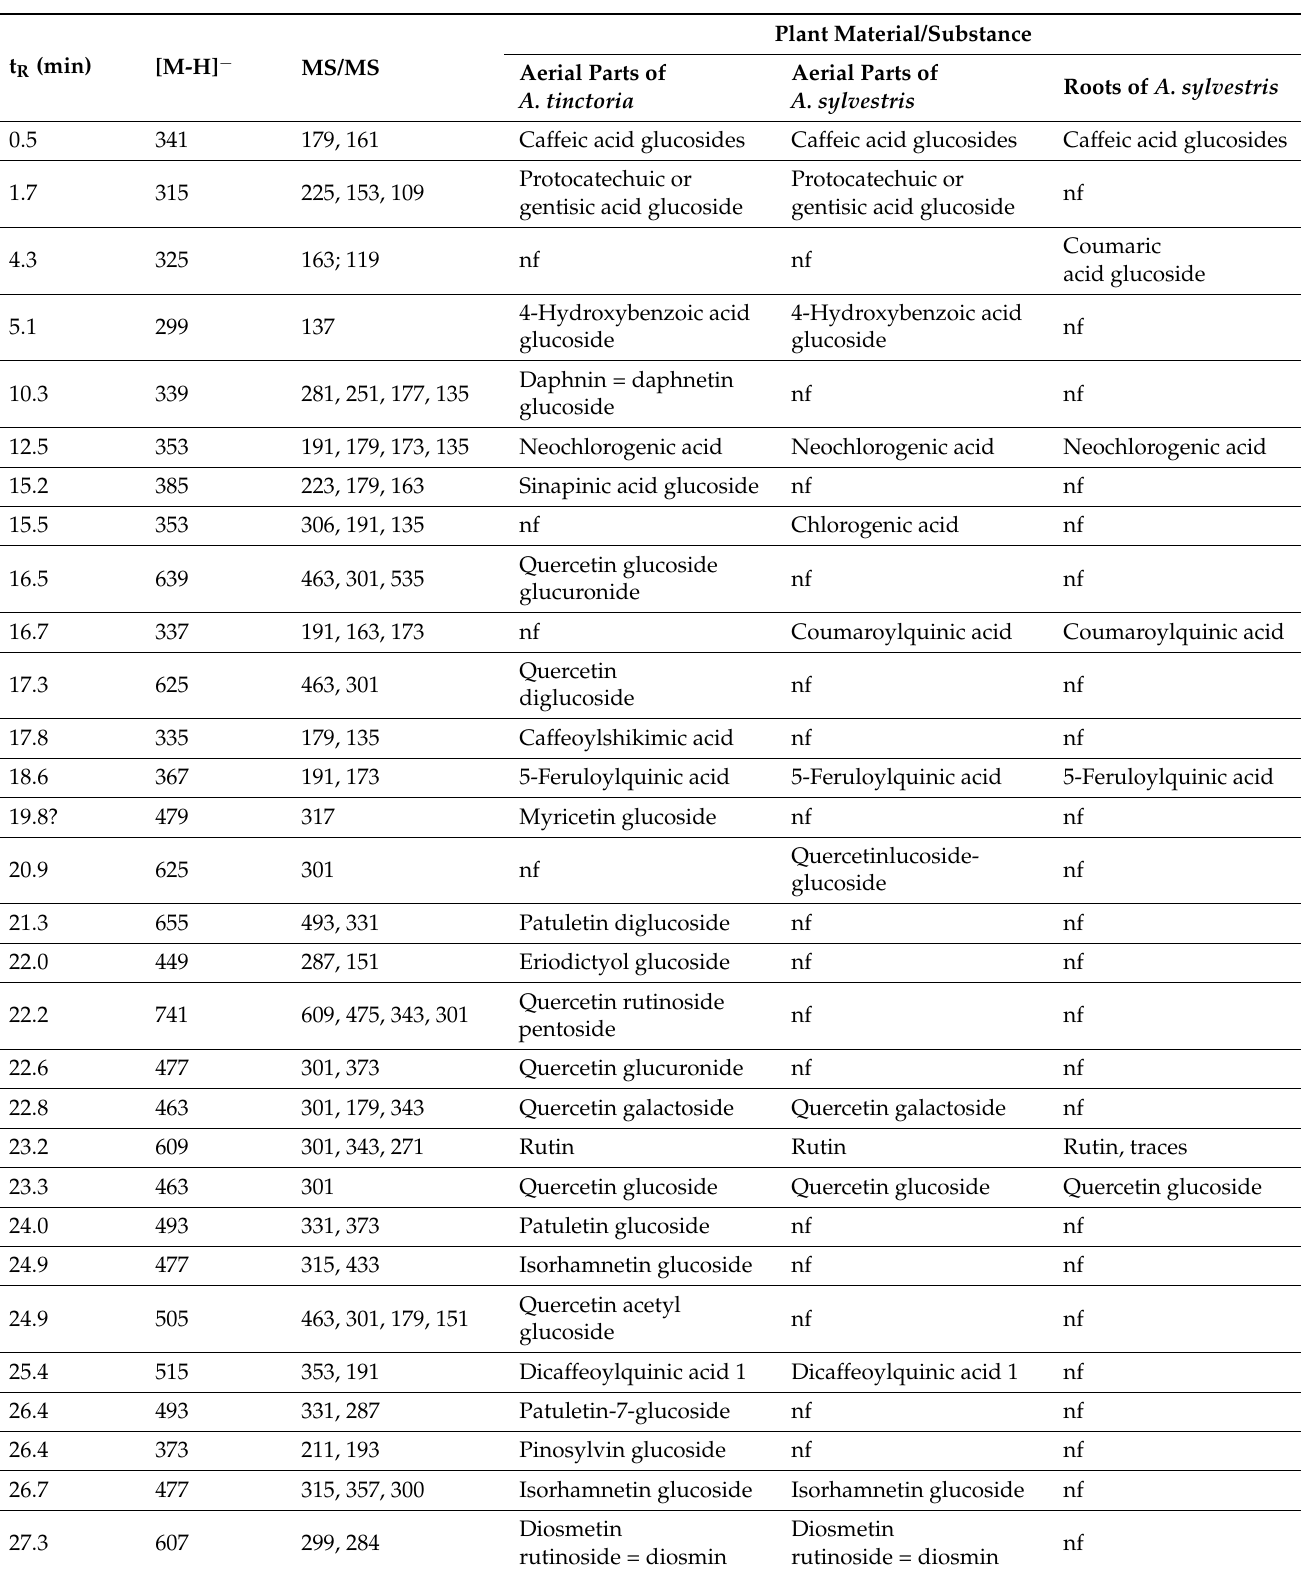
Table 3. Polyphenolic compounds identified in the methanolic extracts of A. tinctoria and A. sylvestris by HPLC-ion trap